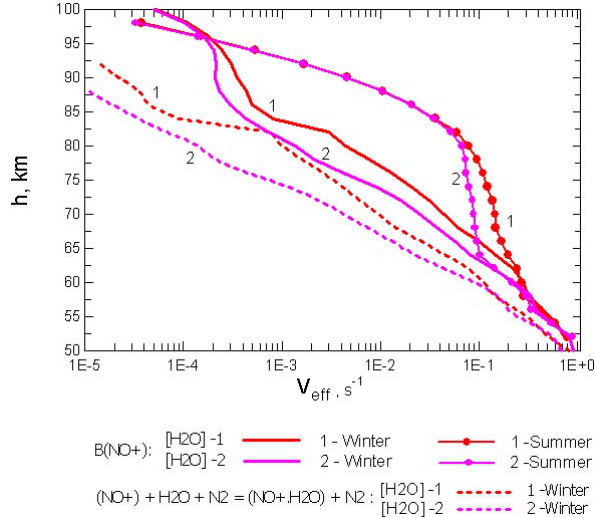
Fig. 3a. Efficiency of the NO + → NO + .H 2 O channel, B (NO + ) , calculated for winter and summer based on the H 2 O-1 and H 2 O- 2 profiles. Dashed curves 1 and 2 show the vertical profiles of the efficiency for NO + ion direct hydration.